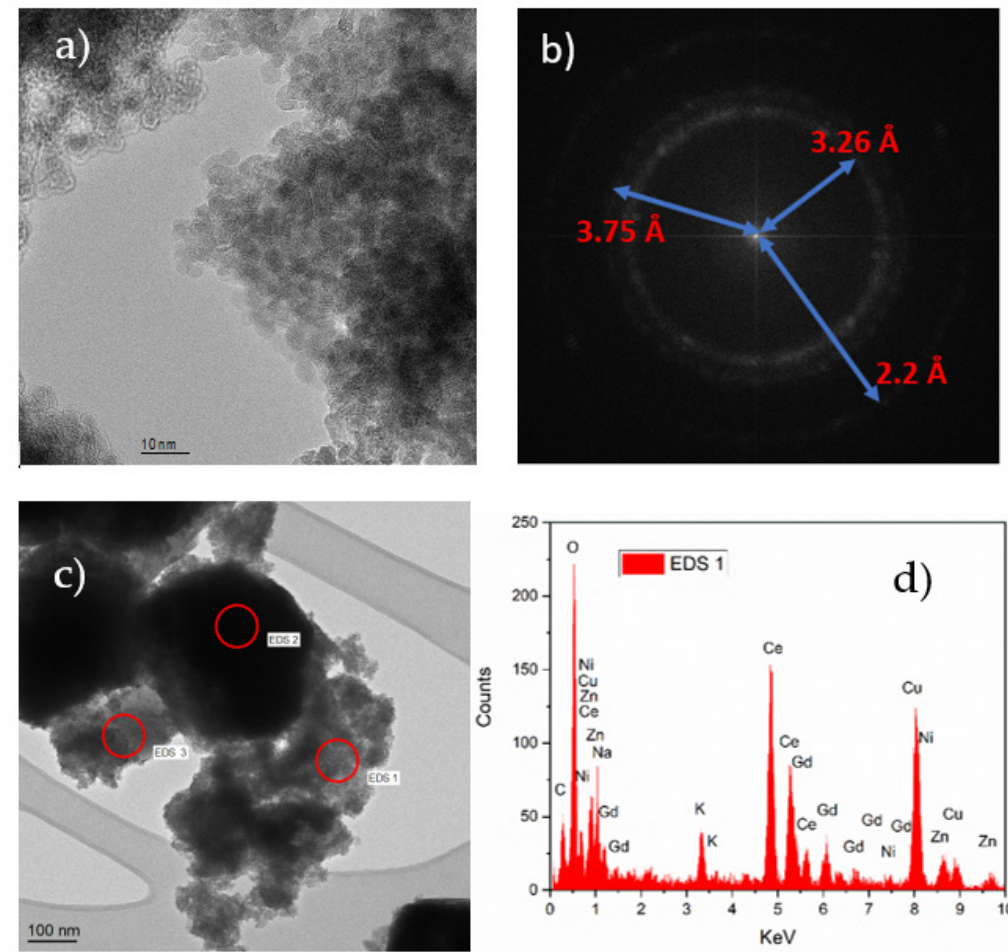
Figure 4. ( a ) High magnification HR-TEM image of the Li 0.15 Ni 0.45 Zn 0.4 O 2 -Gd 0.2 Ce 0.8 O 2 -Li 2 CO 3 -Na 2 CO 3 -K 2 CO 3 composite material which was in a powder form, ( b ) HR-TEM image after applying FFT filter, ( c ) low-magnification HR-TEM image of the Li 0.15 Ni 0.45 Zn 0.4 O 2 -Gd 0.2 Ce 0.8 O 2 -Li 2 CO 3 -Na 2 CO 3 -K 2 CO 3 composite powder, ( d ) EDS of the composite powder.